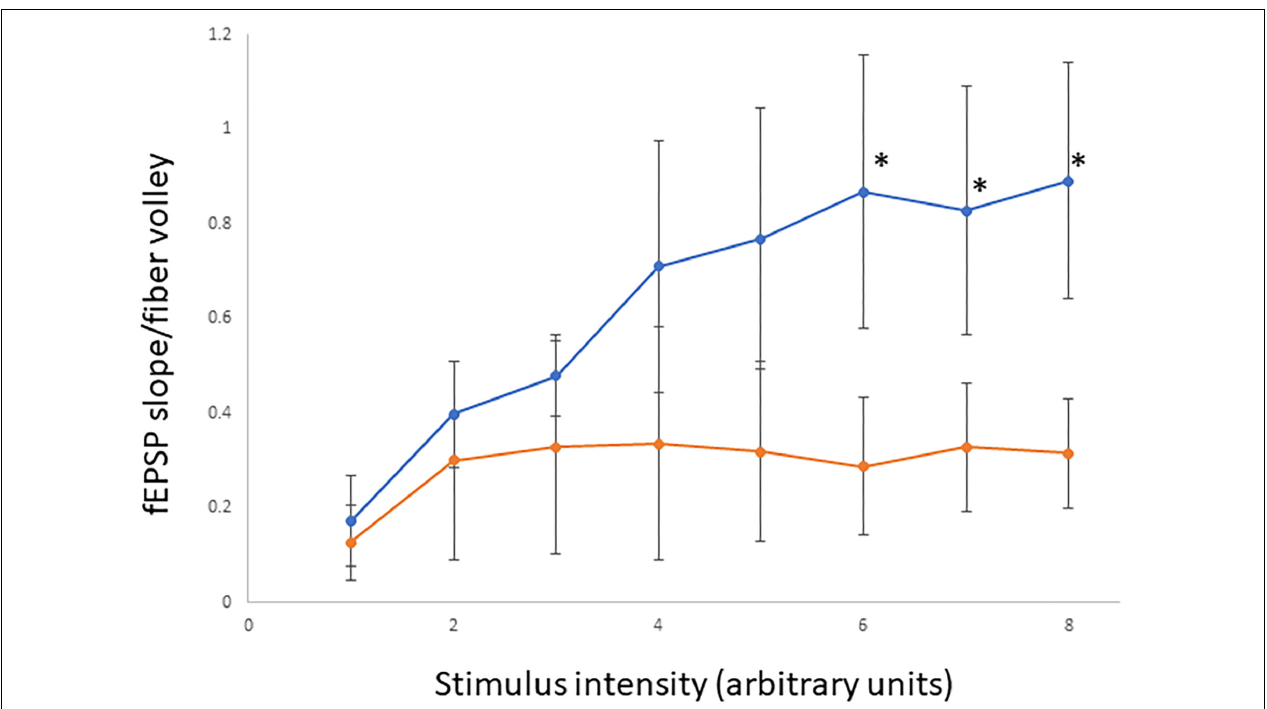
FIGURE 8 | Assessment of basal synaptic transmission in CA1 region of hippocampus. Input/output curves representing synaptic responses (fEPSP slope/fiber volley) resulting from different stimulus intensities. Stimulus intensity numbers are arbitrary units; where 1 is intensity that gives minimum response and 8 is intensity that produces maximum response. Synaptic responses were significantly lower in A350V IQSEC2 mice (orange) compared to WT IQSEC2 mice (blue). Data represent mean ± SEM, n = 5 wild type IQSEC2 mice and n = 4 A350V IQSEC2 mice, ∗ p ≤ 0.05, t -test,